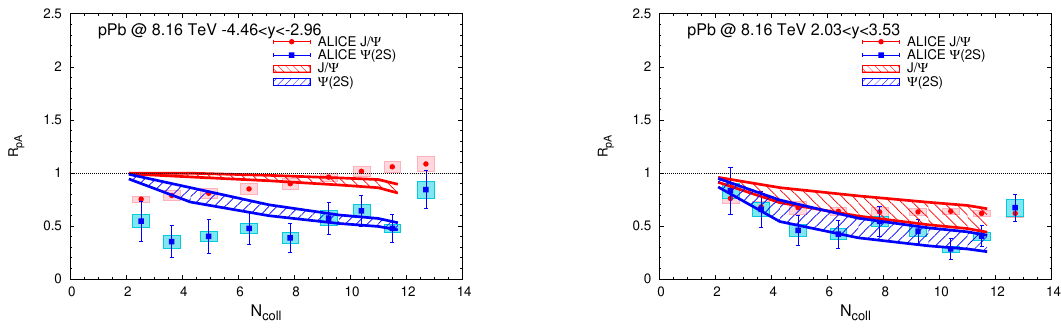
Figure 5 . Centrality-dependent R p A for J= (red bands) and (2 S ) (blue bands) in 8.16 TeV p -Pb collisions, compared with experimental data [17]. The left (right) panel is for backward (forward) rapidity. The bands are due to anti/-shadowing from an EPS09 LO/NLO [47, 48] at forward (backward)